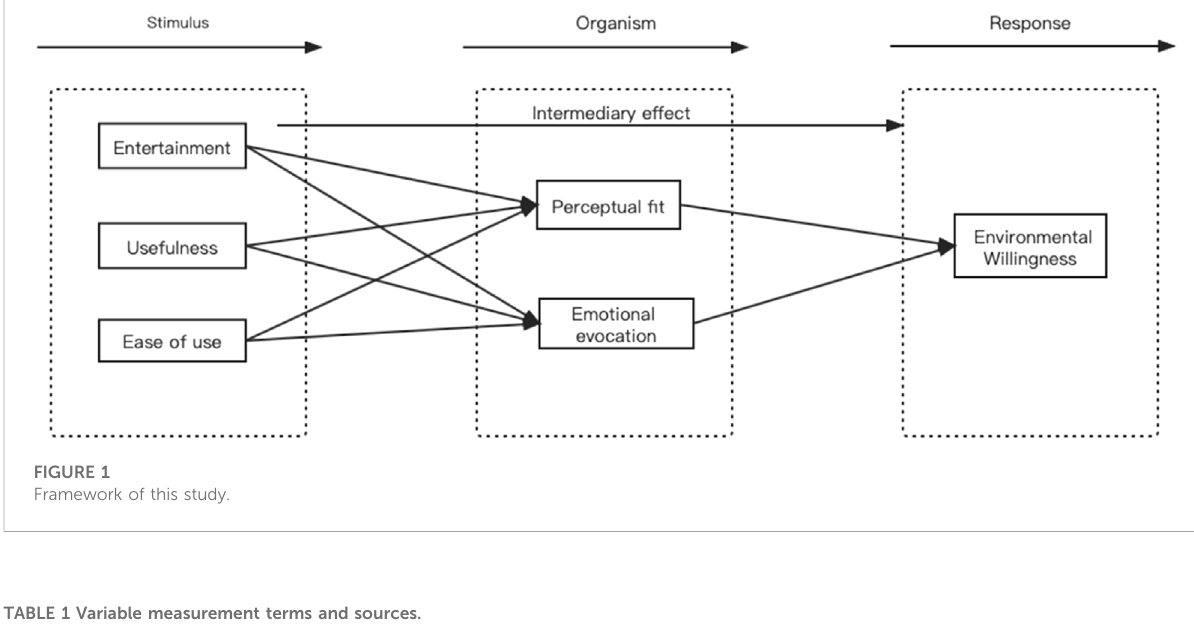
TABLE 1 Variable measurement terms and